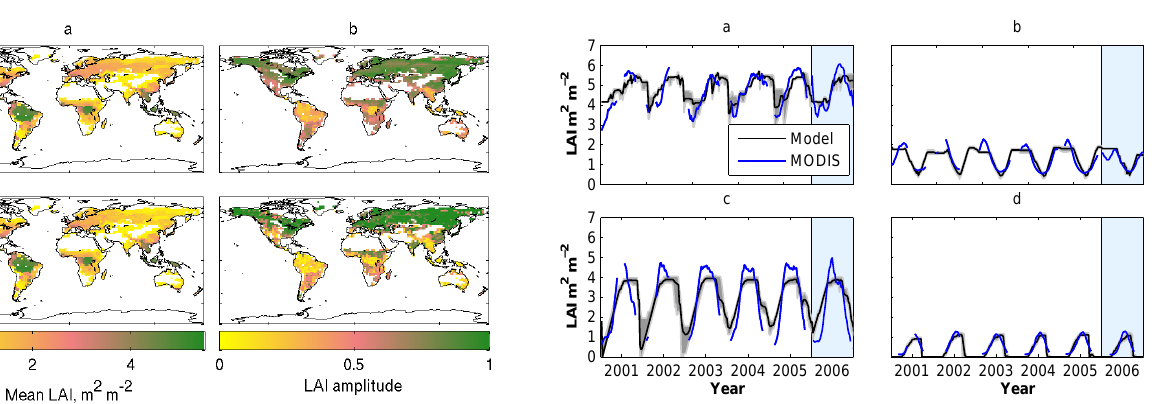
Fig. 2. (a) Mean observed MODIS (top) and predicted (bottom) LAI and (b) relative annual amplitude expressed as the seasonal ampli- tude normalised by the maximum LAI value. Values calculated for the period 2001–2005.